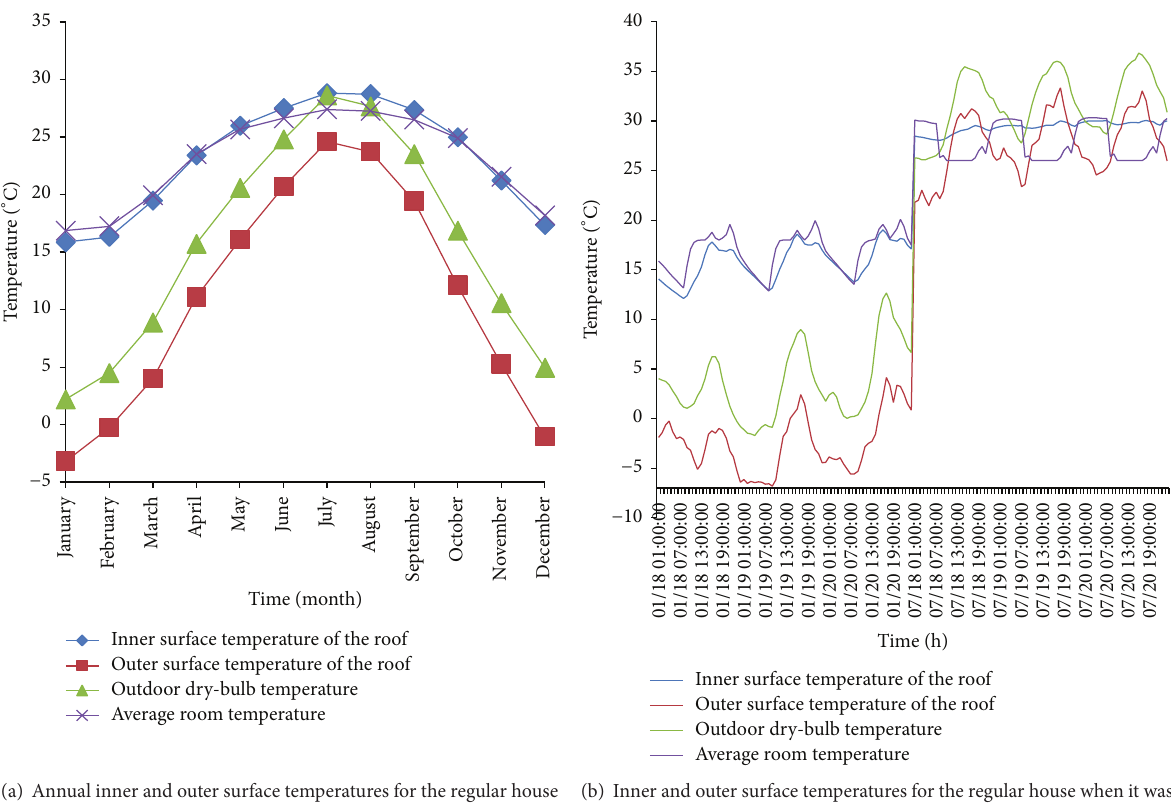
(a) Annual inner and outer surface temperatures for the regular house when it was not exposed to sunlight Figure 4: Simulated inner and outer surface temperatures for the regular house when it was not exposed to sunlight.